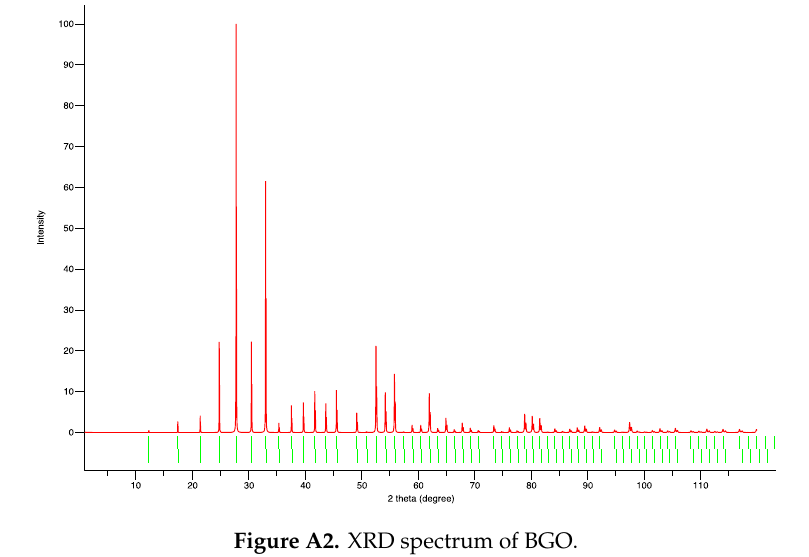
Figure A1. Crystal cell structure of BGO .